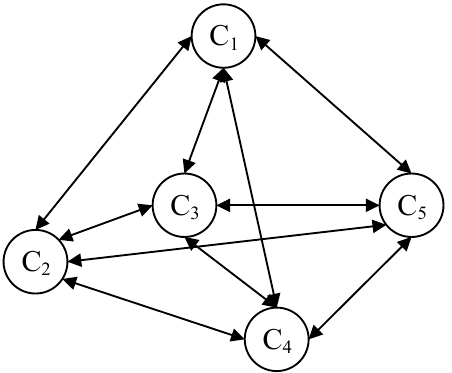
Figure 6. Fuzzy cognitive map of the lunar landing site selection.